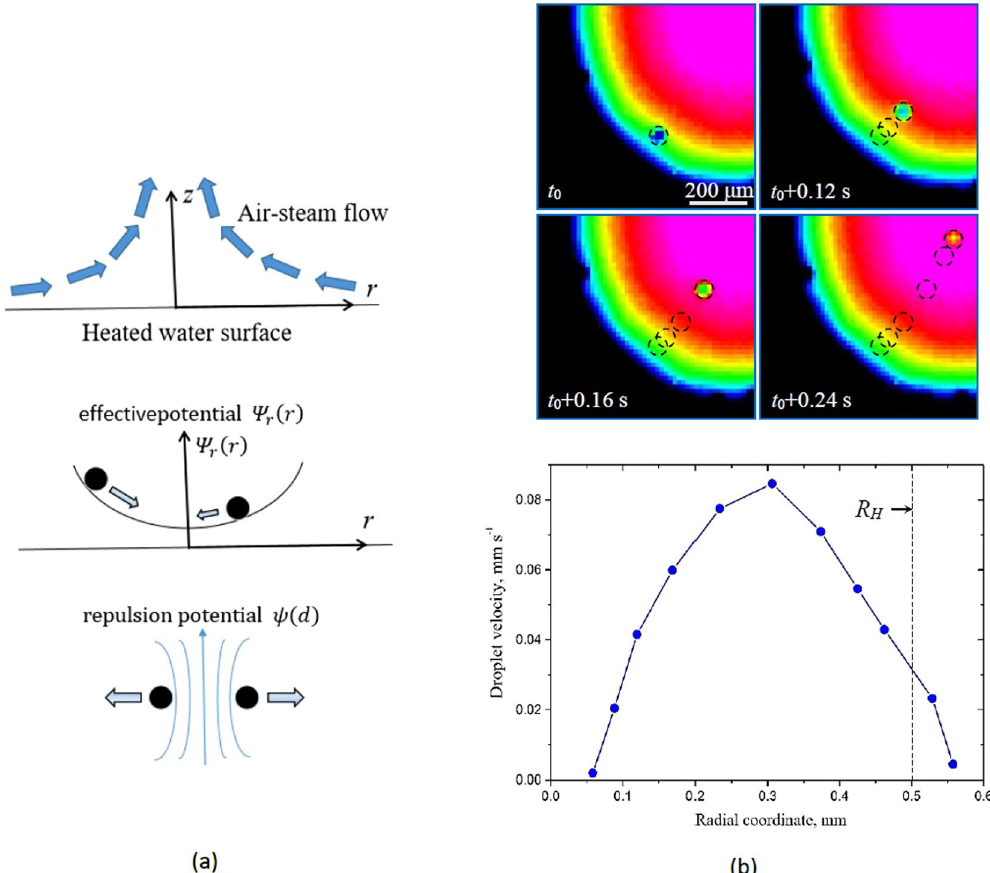
Figure 4. ( a ) The air-steam flow over the heated water surface creates pressure gradient causing droplets to levitate. The r -component of the drag force can be approximated with an effective potential and is minimal at the center. The repulsion force between the droplets can be presented as a repulsion potential. Together, dragging droplets to the center combined with the repulsion results in the observed packing of the droplets minimizing the total potential Ψ total and thus leading to the self-assembly as evidenced by Voronoi entropy decrease. ( b ) Experimental observation of the velocity dependence on the distance from the center for a single